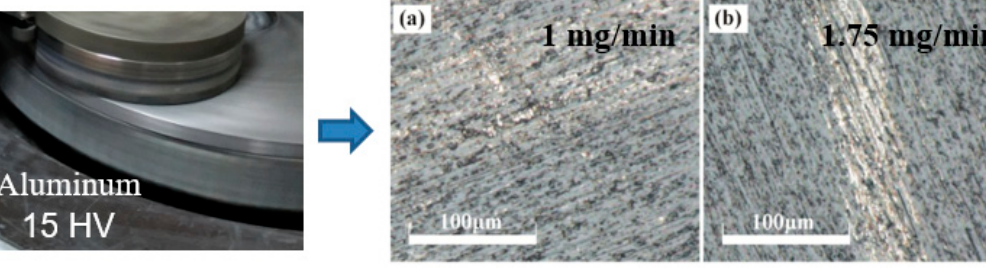
Materials 2021 , 14 , x FOR PEER REVIEW